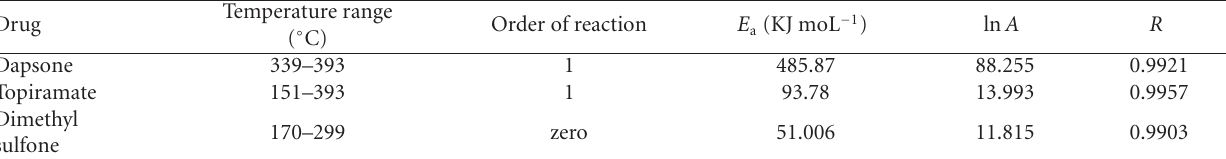
Table 2: Kinetic parameters from the Arrhenius equation for Dapsone, Topiramate, and dimethyl sulfone. Drug